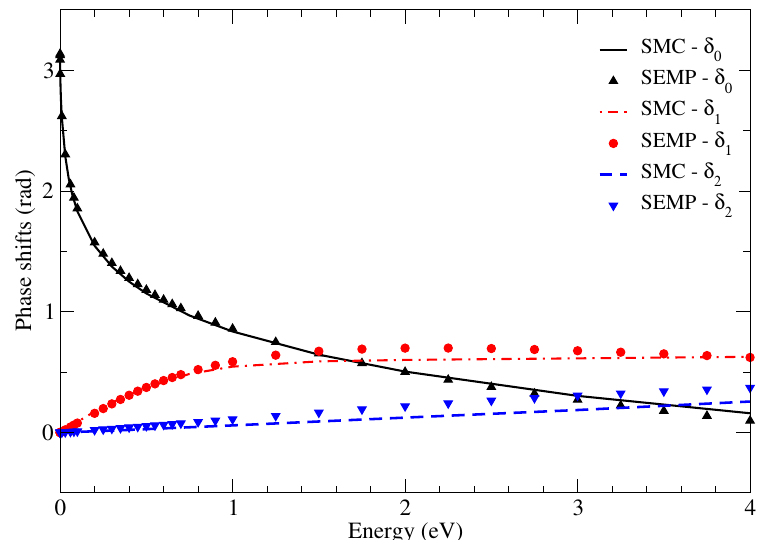
Figure 2. Phase shifts in radians as a function of the impact energy in eV computed with the SMC and the semiempirical model (SEMP) according to the SMC reference data: A = 20.1 a 0 , α d = 45.6 a 3 , and ρ = 3.1069 a 0 (see the first line of Table 2). δ 0 , δ 1 , and δ 2 denote the s-, p-, and d-wave phase 0 shifts, respectively. Some small discrepancies are seen for the p and d waves for energies above 1 eV, while the s wave is well described, as